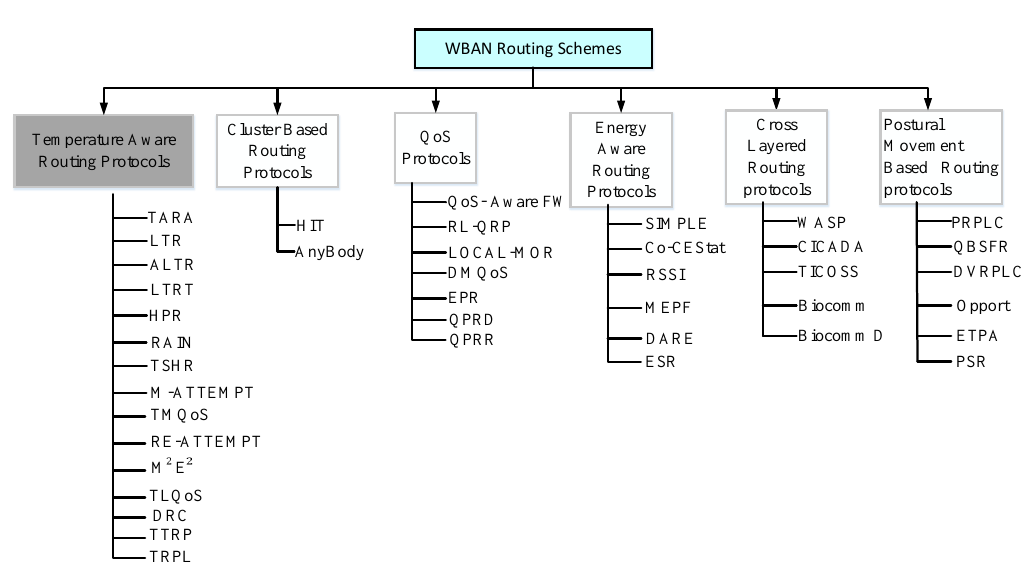
Figure 1. Taxonomy of WBAN routing